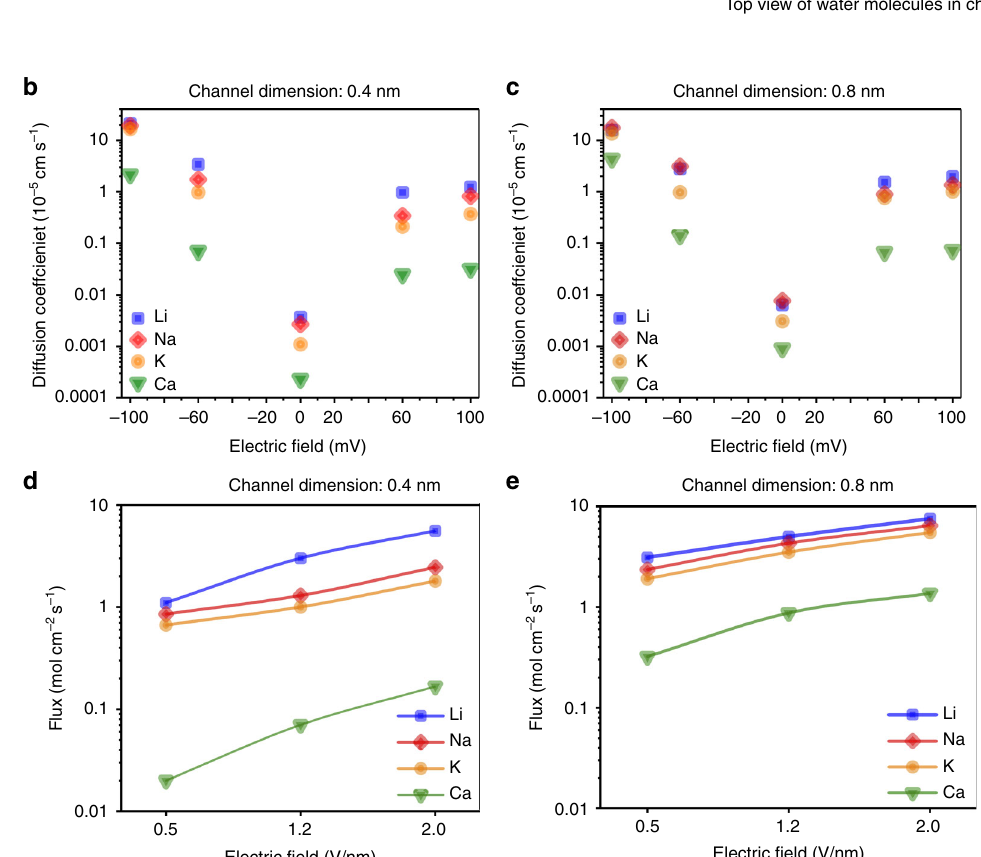
Fig. 4 Effect of nanochannel size on Li-ion transport mechanism. The left two images in a show Li + ions transport behavior and water molecules orientation inside 0.6 and 1.2 nm vermiculite nanochannels respectively, illustrating how the Li + ions jump between the surfaces of the nanochannel in a zig-zag fashion when the interlayer distance is below 1nm 52 . The corresponding two right images exhibit the effect of reducing the nanochannel size to angstrom scale on the water molecular arrangements from side and top view, revealing that the water density and number of layers inside the nanochannel increases upon increasing channel dimension from 4 to 12 Å. b – e MD simulation fi ndings on the effect of change in electric driving force and inter-surface distance of 2D vermiculite membrane on the diffusion coef fi cient of the cations ( b , c ) and their ionic fl ux ( d , e ); solid lines are guides to the eye 52